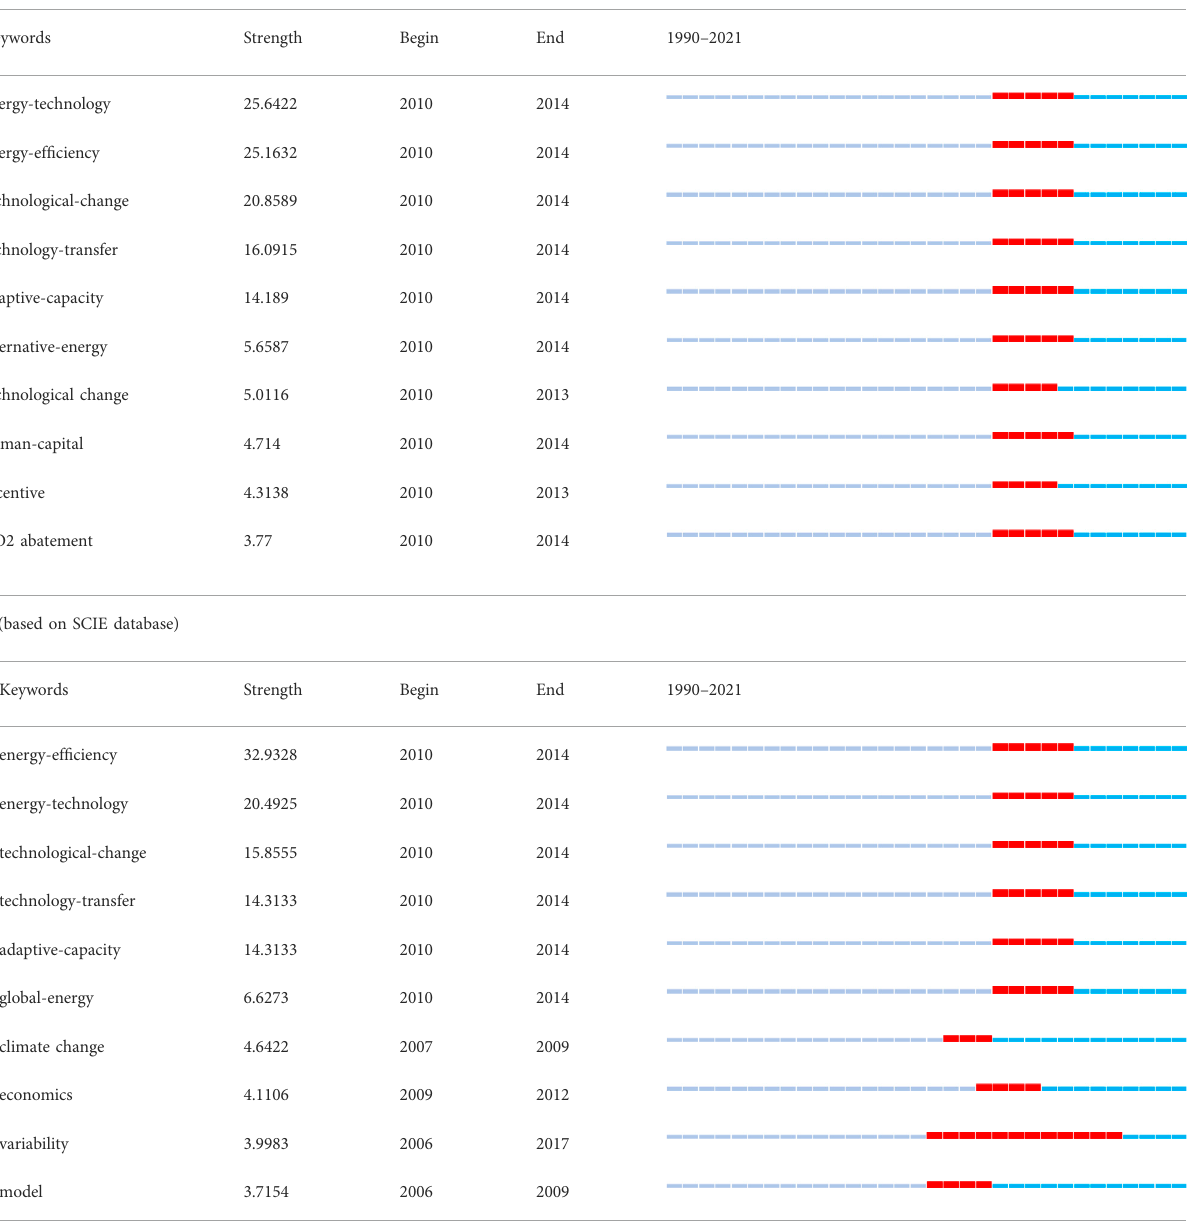
TABLE 7 Top 10 keywords with the strongest citation